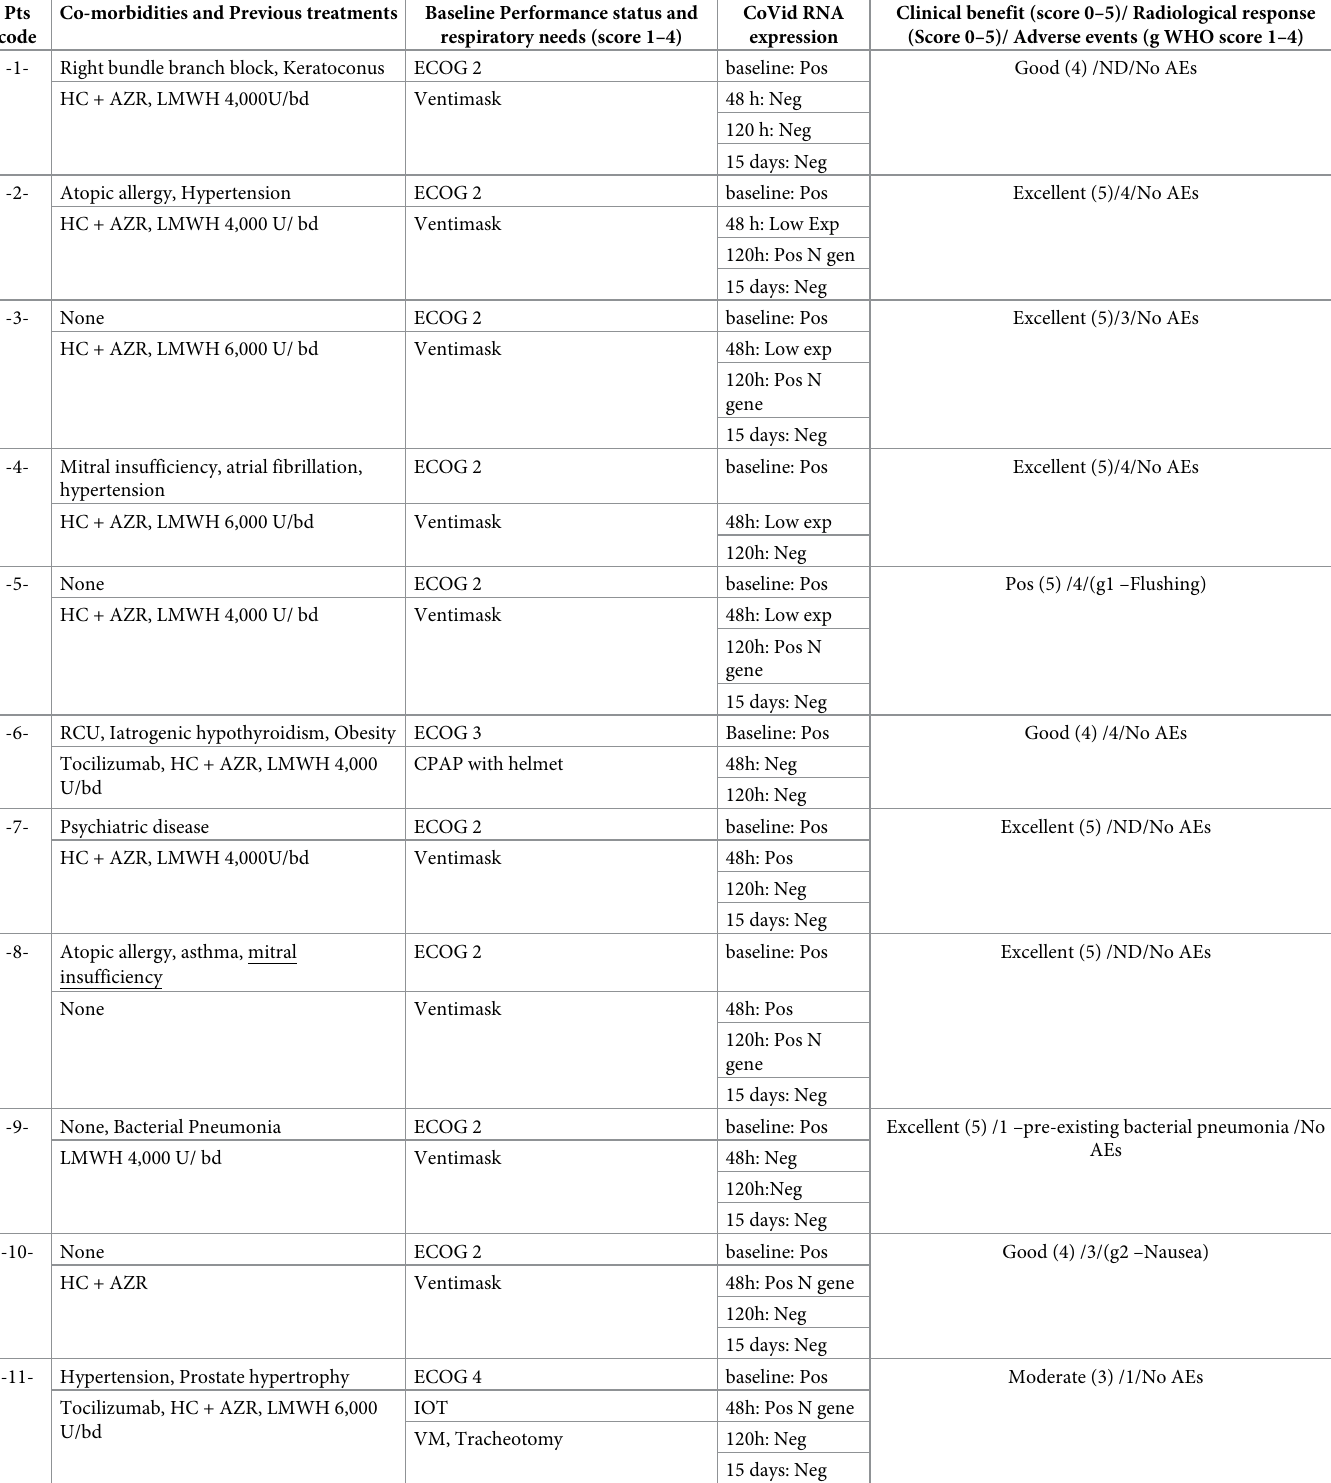
Table 1. Patient features, treatments, and outcome. Pts Co-morbidities and Previous code